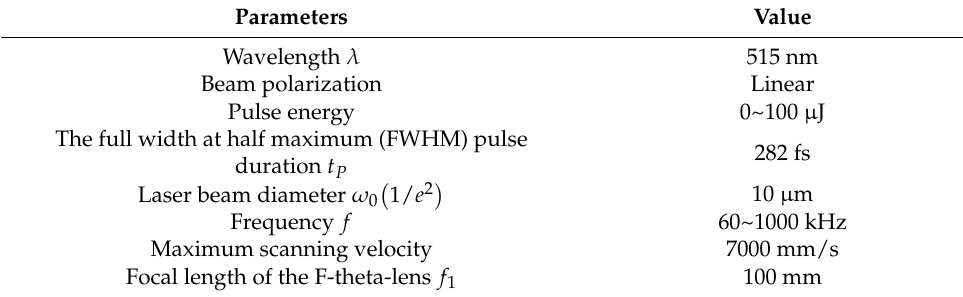
Figure 1. Optical path of femtosecond laser scanning. Table 1. Femtosecond parameters for polishing processing